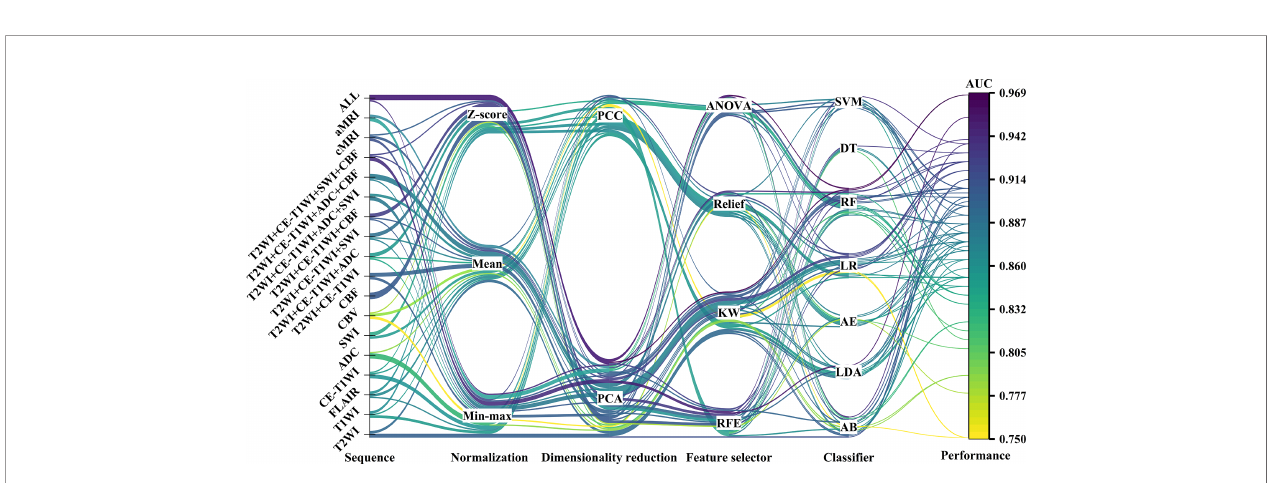
FIGURE 2 | The machine learning pipelines and performance of top- fi ve-performing models of different sequences. The color of lines indicated the performance of models in the test